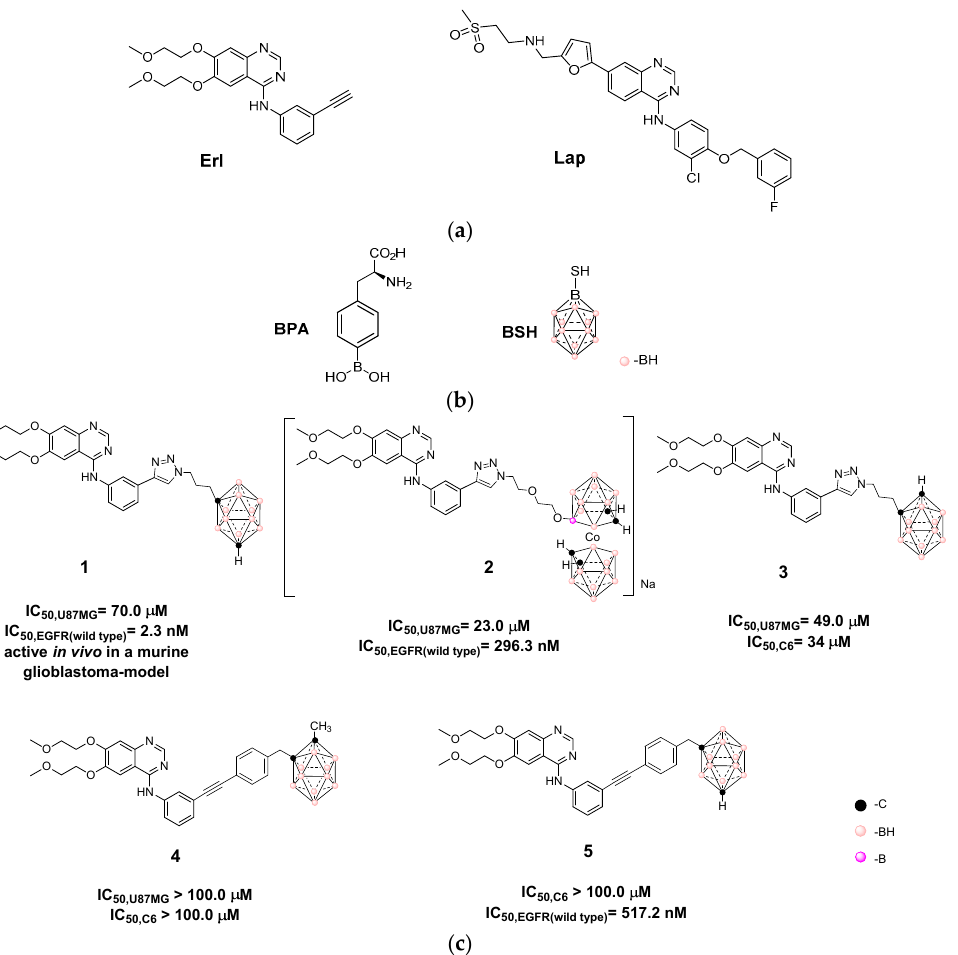
Figure 1. ( a ) Small tyrosine kinase receptors (TKRs) inhibitors erlotinib ( Erl ) and lapatinib ( Lap ); ( b ) Compounds BPA and BSH , clinically used in the treatment of cancer with boron neutron capture therapy (BNCT); ( c ) Closo -carboranyl and metallabis(dicarbollide) clusters as hybrid agents derived from erlotinib, which act as TKRs inhibitor-sca ff old hybrids previously developed by our group [18–21]. IC 50 were measured for U98MG cell line.